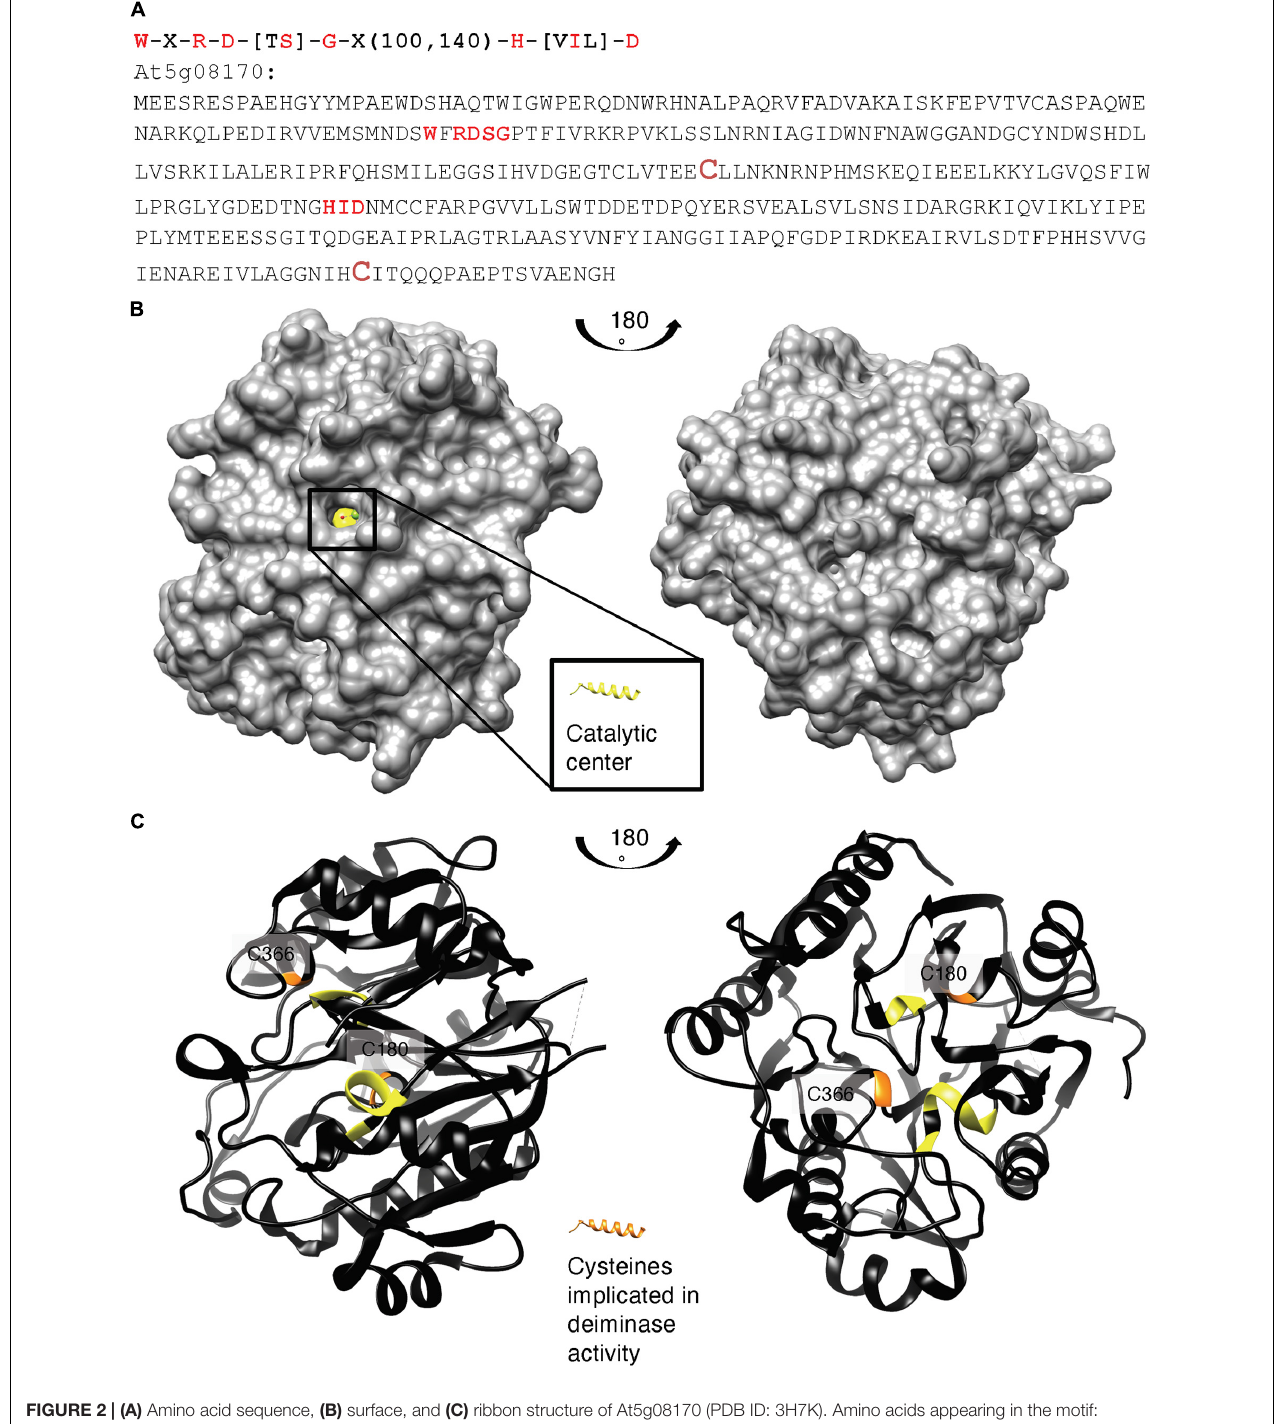
FIGURE 2 | (A) Amino acid sequence, (B) surface, and (C) ribbon structure of At5g08170 (PDB ID: 3H7K). Amino acids appearing in the motif: W-X-R-D-[TS]-G-X(100,140)-H-[VIL]-D are highlighted in red in (A) the full-length At5g08170 amino acid sequence, and colored yellow in (B) the surface and (C) ribbon At5g08170 structures. The cysteines (C180 and C366) implicated in the catalytic activity of agmatine deiminase are highlighted in brownish red in (A) and orange in (C) , the ribbon structures. Amino acids R93–G96 from the motif occupy a clear cavity that can spatially accommodate an R residue (B) and thus is assigned the catalytic center for arginine deiminase (highlighted in yellow). All analyses and images were created using UCSF Chimera (ver. 1.10.1). Chimera was developed by the Resource for Biocomputing, Visualization, and Informatics at the University of California, San Francisco (supported by NIGMS P41-GM103311).